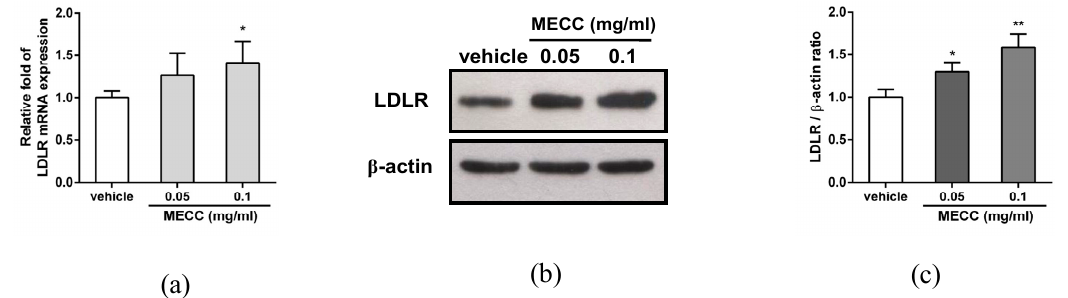
Figure 2. Effects of MECC on the LDLR expression in HepG2 cells. HepG2 cells were cultured in LPDS medium and treated with vehicle (0.1% DMSO) or MECC (0.05 and 0.1 mg/mL) for 24 h. ( a ) The level of LDLR mRNA was measured by reverse transcription real-time PCR analysis. ( b ) The levels of LDLR and β -actin proteins were analyzed by Western blot analysis. The experiments were replicated three times, and a representative blot was shown. ( c ) The intensity of LDLR normalized to the β -actin protein is presented as the means ± SD of three independent experiments. * p < 0.05 and ** p < 0.01 represent significant differences compared to the vehicle-treated group.